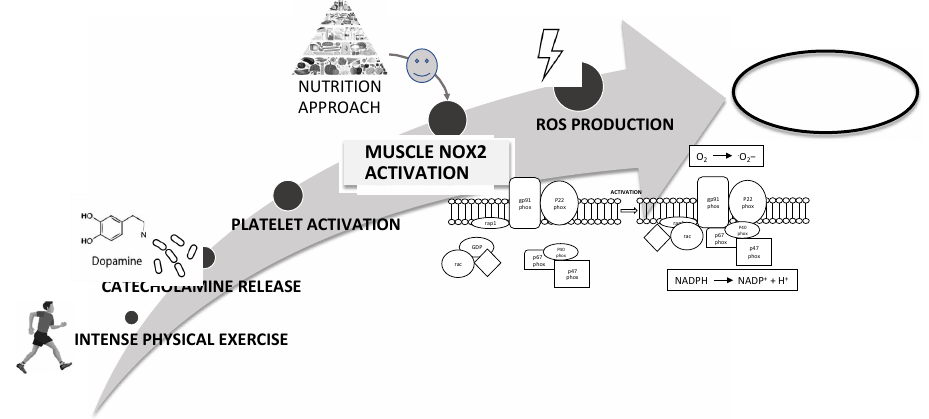
Figure 8 . Schematic representation of intensive exercise-induced muscle injury via NOX2-mediated oxidative stress as a fundamental mechanism in the impairment of muscle cell integrity. A possible nutrition strategy using foods with antioxidant could reduce NOX2 activation and muscle injury improving athletic performance.